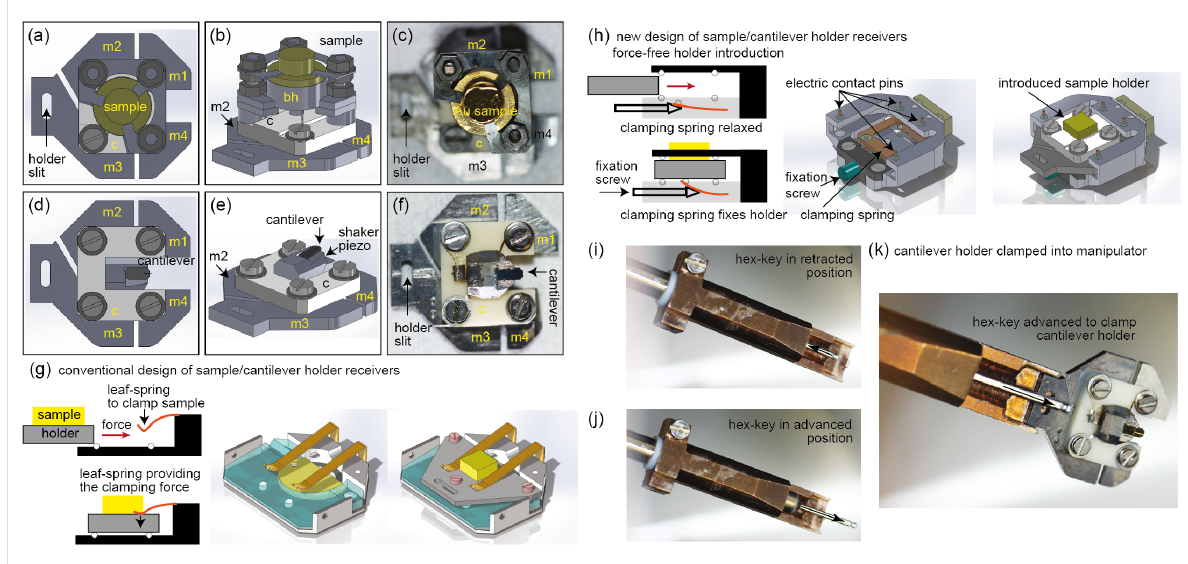
Figure 7: (a, b) Top and side view CAD sketches of a sample holder with a button heater for sample preparation. (c) A hat-shaped Au(111) single crystal mounted in a sample holder containing a button heater. (d, e) Top and side view CAD sketches of a cantilever holder with a shaker piezo inte- grated into the holder below the cantilever. (f) A cantilever holder with a mounted (glued) cantilever. The wire on the top right to the m1 contact plate is for the measurement of the tunneling current. The wire on the top left contacts the cantilever shaker piezo, while the wire on the bottom left provides the ground and shields the cantilever excitation voltage from the cantilever. (g) Typical sample/cantilever receiver design used in earlier instruments [45] where the sample/cantilever holder are clamped down by springs. (h) New sample/cantilever receiver design used here, permitting a force-free introduction/removal of the sample/cantilever from the corresponding receiver. (i, j) Manipulator with a rotatory hex-key end piece that can be moved along its long axis to clamp a sample/cantilever holder for a safe transport between the chamber transport system and the sample/cantilever holder receiver in the AFM